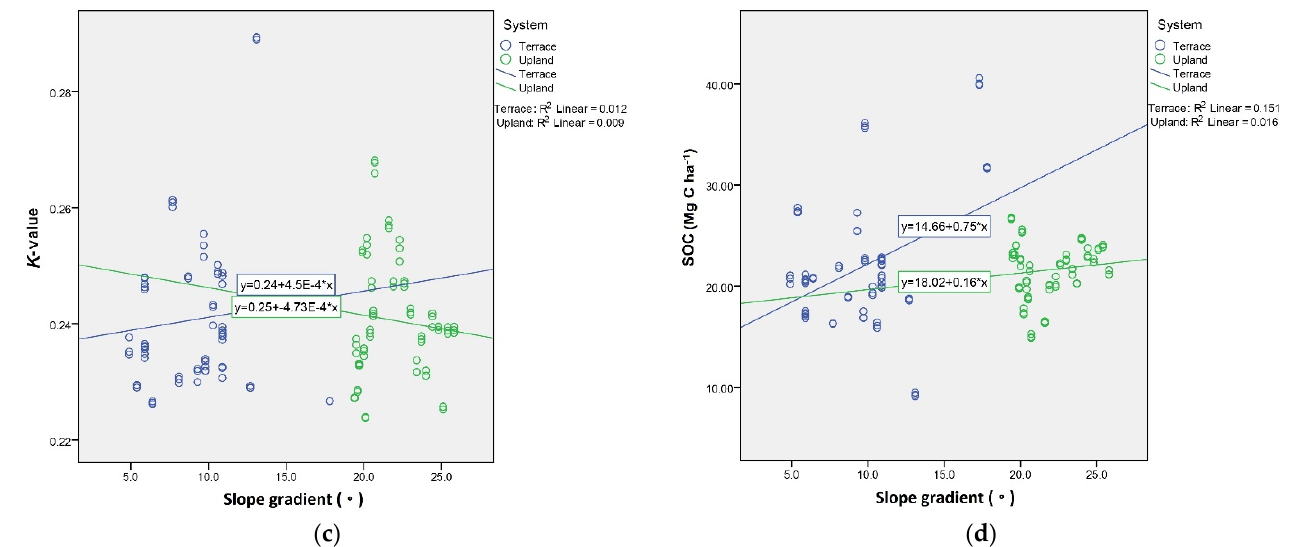
Figure 5. Soil organic carbon (Mg·C·ha − 1 , bar area) and K -value (line) of under different toposequences, and trend analysis charts of soil organic carbon and K -value. ( a ) Upland rice area, ( b ) terraced paddy field, ( c ) trend analysis chart of K -value and ( d ) trend analysis chart of SOC stock.